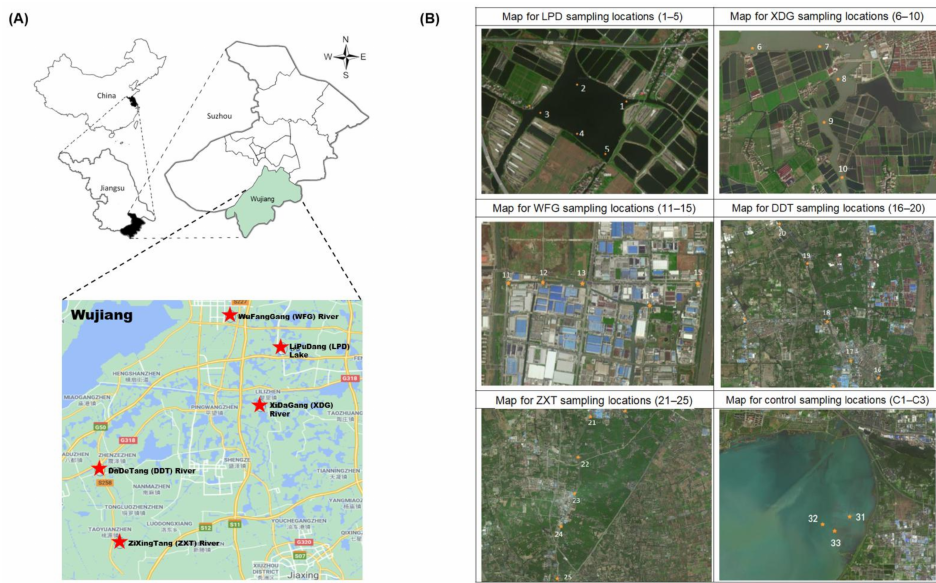
Figure 1. Maps of study areas in Wujiang District, Suzhou, China ( A ); Maps of sampling locations in the lake and rivers in Wujiang District ( B